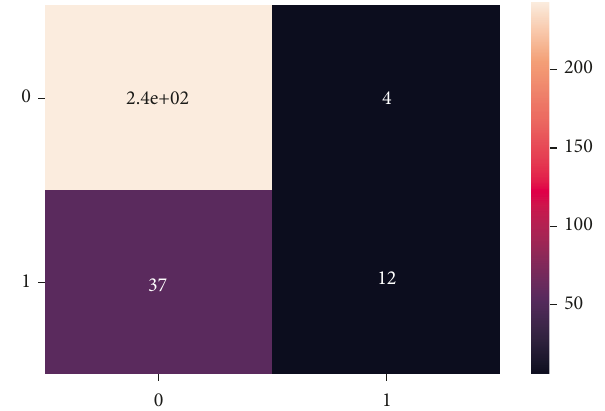
Figure 8: Confusion matrix of collective SVM kernel response.